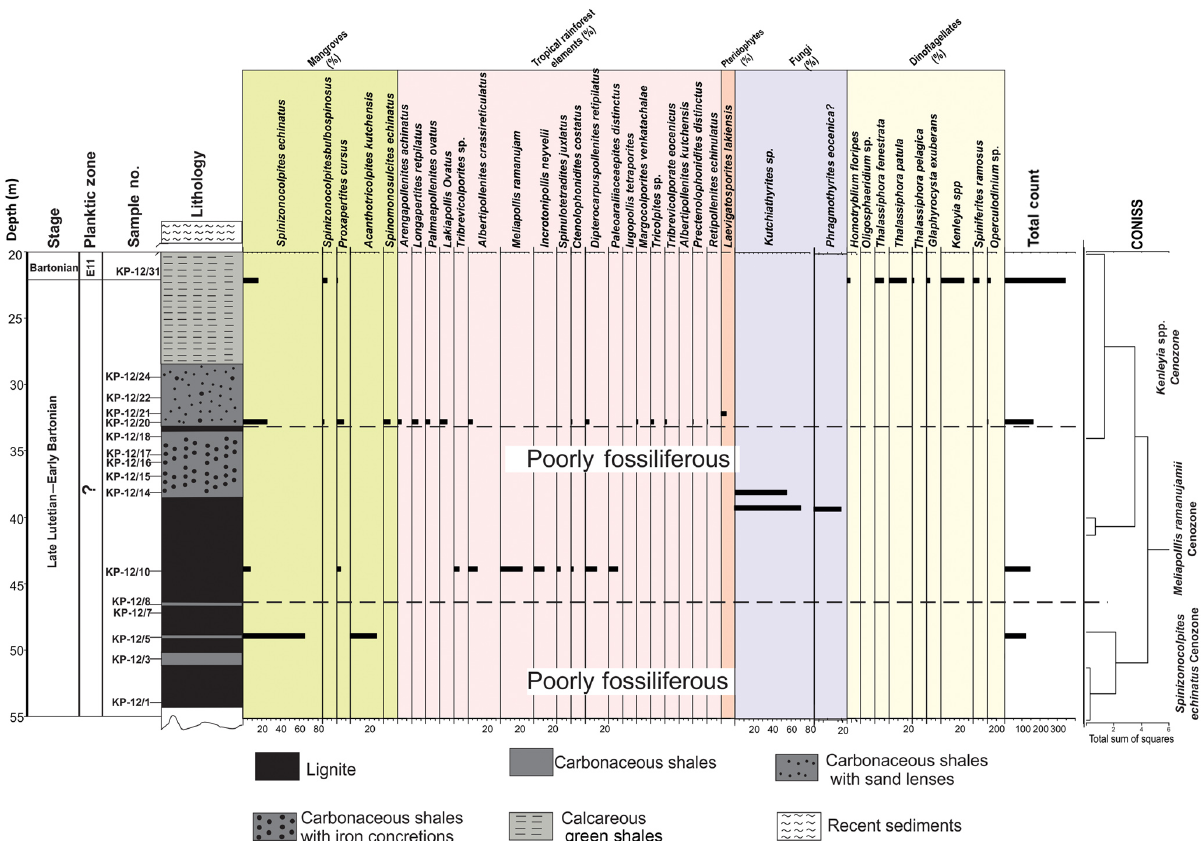
Figure 6. Percentage distribution of palynomorphs in the Panandhro lignite mine section, Kutch Basin.